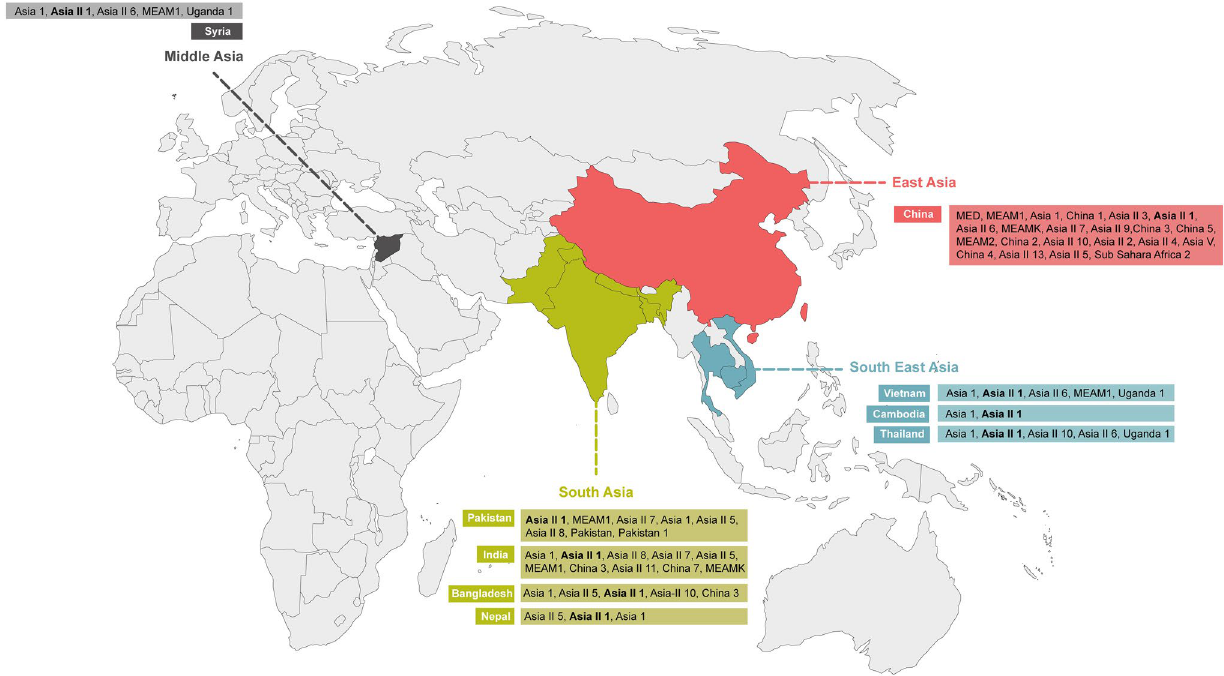
Figure 9. Geographical distribution of B. tabaci species across the world. The presence of different species identified from different geographical locations is indicated in multiple colors. Asia II 1 identified from different countries is in bold font. The world map was collected from https:// simpl emaps. com and modified using CorelDRAW